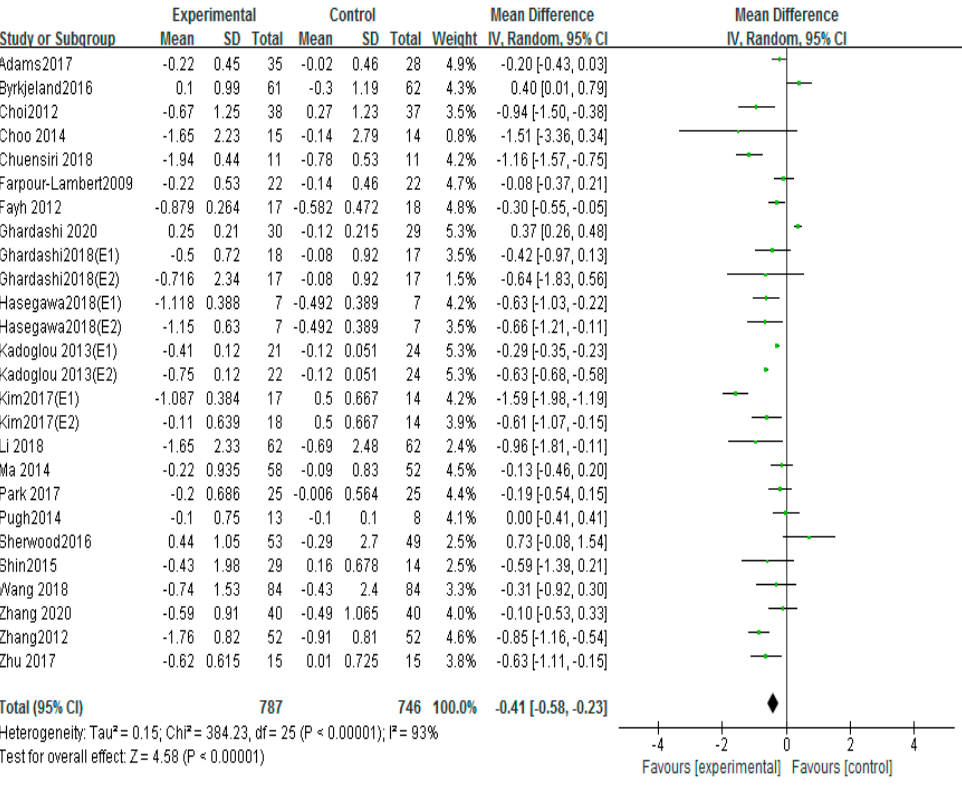
Figure 6. Meta − analyses of the e ff ect of exercise on TC compared with the control groups [12,13,